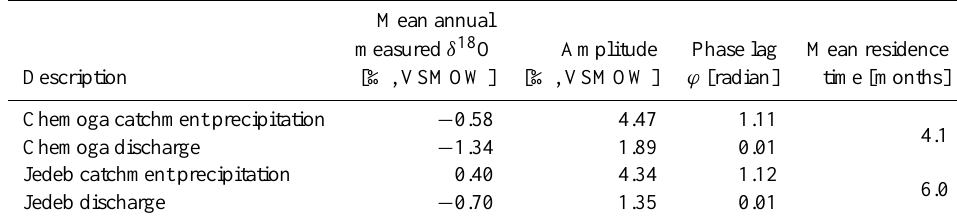
Table 6. Amount-weighted mean precipitation and flow δ 18 O composition, estimated amplitude, phase lag ϕ and mean residence time in the Chemoga and Jedeb catchments over the period July 2009–August